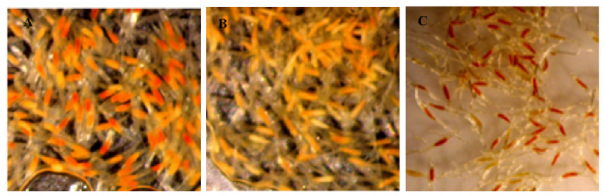
Figure 2. TTC-stained seeds subjected to the “stepped” cryopreservation process without any cryopreservation substances. Viable seeds (dark red embryos) and non-viable (pale embryos). A) Epidendrum quitensium , B) Sobralia rosea , C) Epidendrum anderssonii .